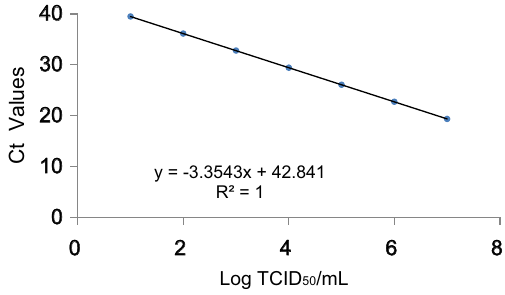
Figure 3. One-step real-time RT-PCR standard curve for Nipah virus. The virus stock was serial diluted (1:10) and viral RNAs were extracted from these serial dilutions. Ct values of the range of dilutions covering 7 Log 10 were used to draw the standard curve. The corresponding virus titre was calculated based on the standard